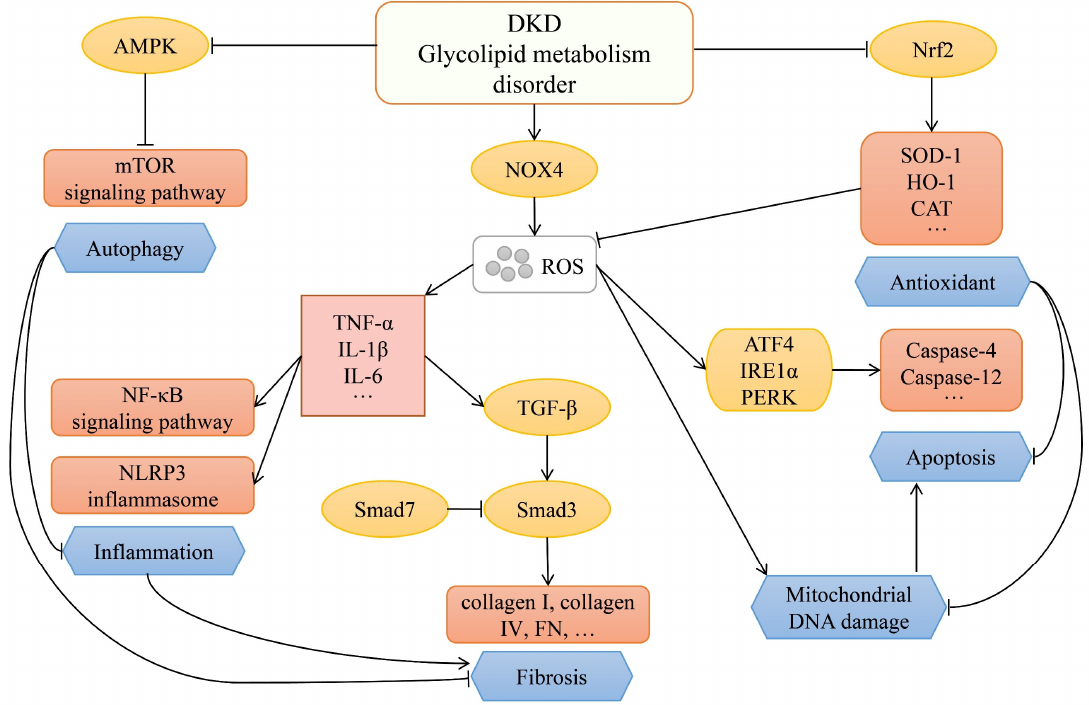
Figure 1. Some pathophysiological mechanisms of